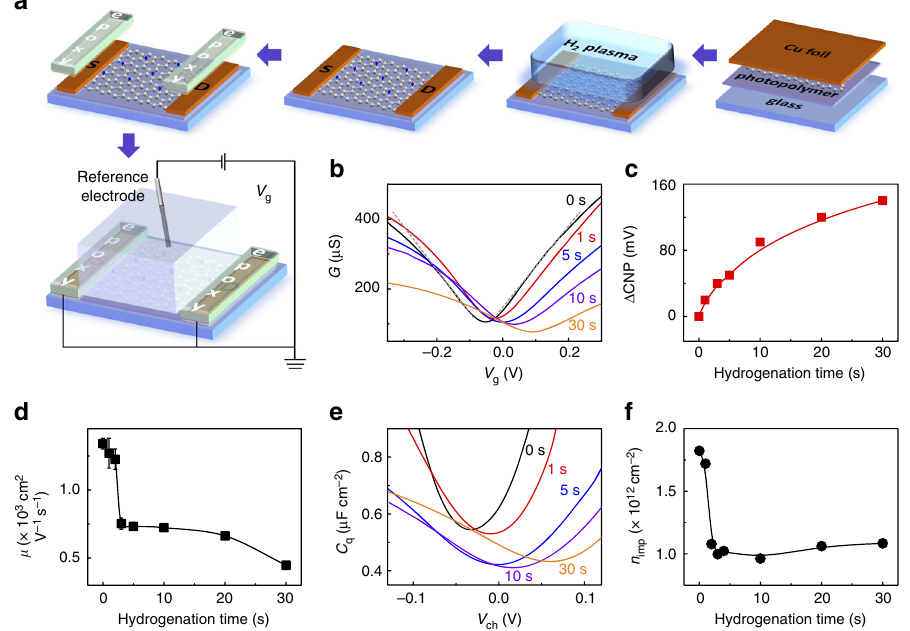
Fig. 2 Transport characteristic and quantum capacitance of CVD graphene upon hydrogenation. a Illustration of the fi eld effect transistor setup fabricated from CVD graphene. b Room temperature conductance ( G ) plots as a function of the gate voltage ( V g ) showing the p-doping effect upon hydrogenation from 0 to 30 s. The gray dashed line is a guide-to-the-eye, highlighting the sublinear behavior of the G ( V g ) curves. c The shifts of the charge neutrality point (CNP) upon hydrogenation. d The carrier mobility of graphene, µ , vs the hydrogenation time. e Quantum capacitance C q of graphene measured as a function of V ch for 0 – 30 s of hydrogenation. f Impurity density n imp vs hydrogenation time. The electrolyte solution is 0.1 M KCl with 10 mM Tris (pH 8). The error bars in d , f are the standard deviation of experimental